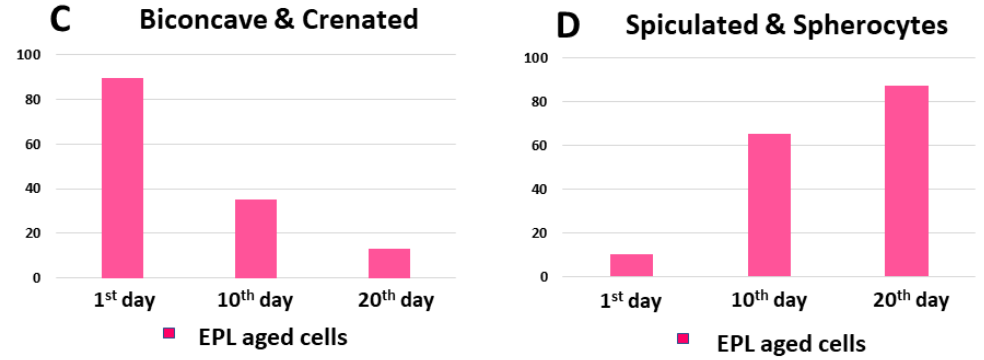
Figure 8. Comparison between the percentages of the morphological types of newly isolated cells from healthy controls treated with H 2 O 2 ( A , B ) and EPL erythrocytes 10-day-old and 20-day-old ( C , D ). Non-parametric Wilcoxon test was applied to determine statistical differences in the value of the fraction of different morphological types of H 2 O 2 treated cells, which are given as p values, indicated as * p < 0.05 relative to the respective morphological fractions of 10-day-aged EPL eryth- rocytes.